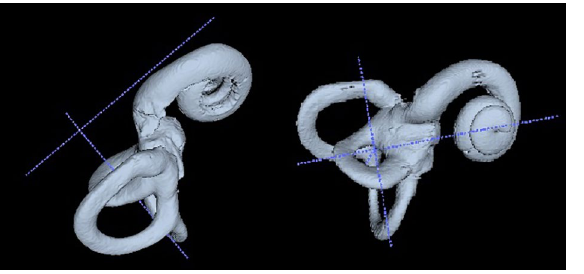
Figure 5. Different viewpoints of 3D reconstruction of the inner ear with the cochlea from the AutoCasU-Net segmentation output. ITK-SNAP 65 (v 3.4.0, http://www.itksn ap.org/) was used for the 3D visualisation of the segmentation